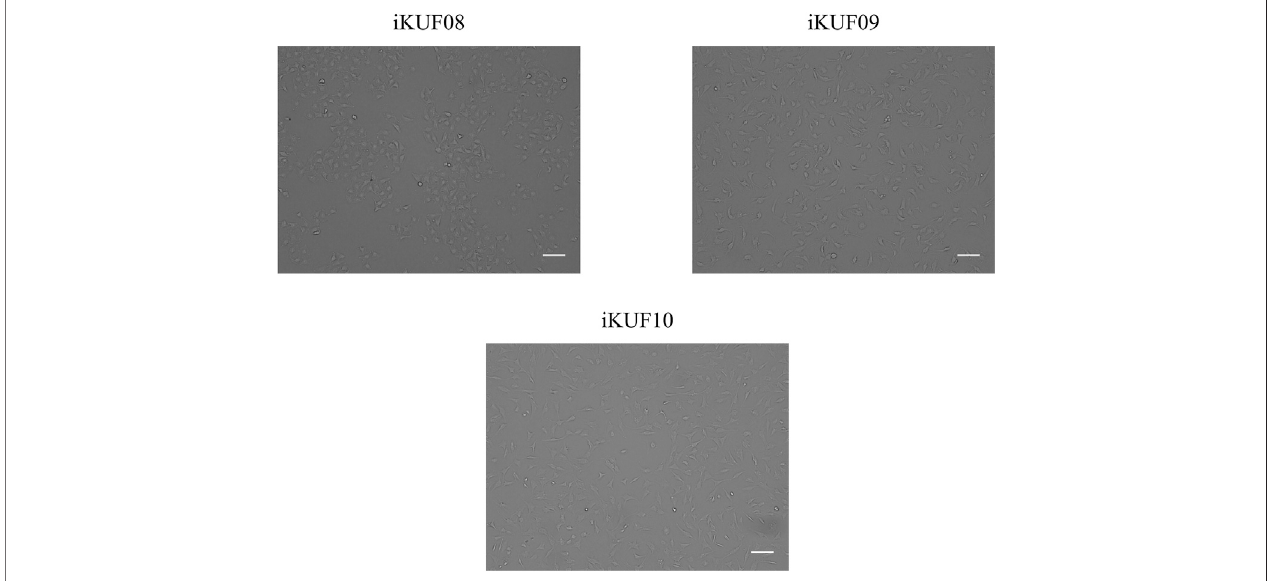
( Supplementary Figure S1 ). The level of hTERT expression varied among the cell lines with iKUF01, iKUF05, iKUF08, iKUF09, and iKUF10 showing the highest levels of expression. The level of hTERT expression was not directly related to proliferation rate ( Figure 2 and Supplementary Figure S1 ).